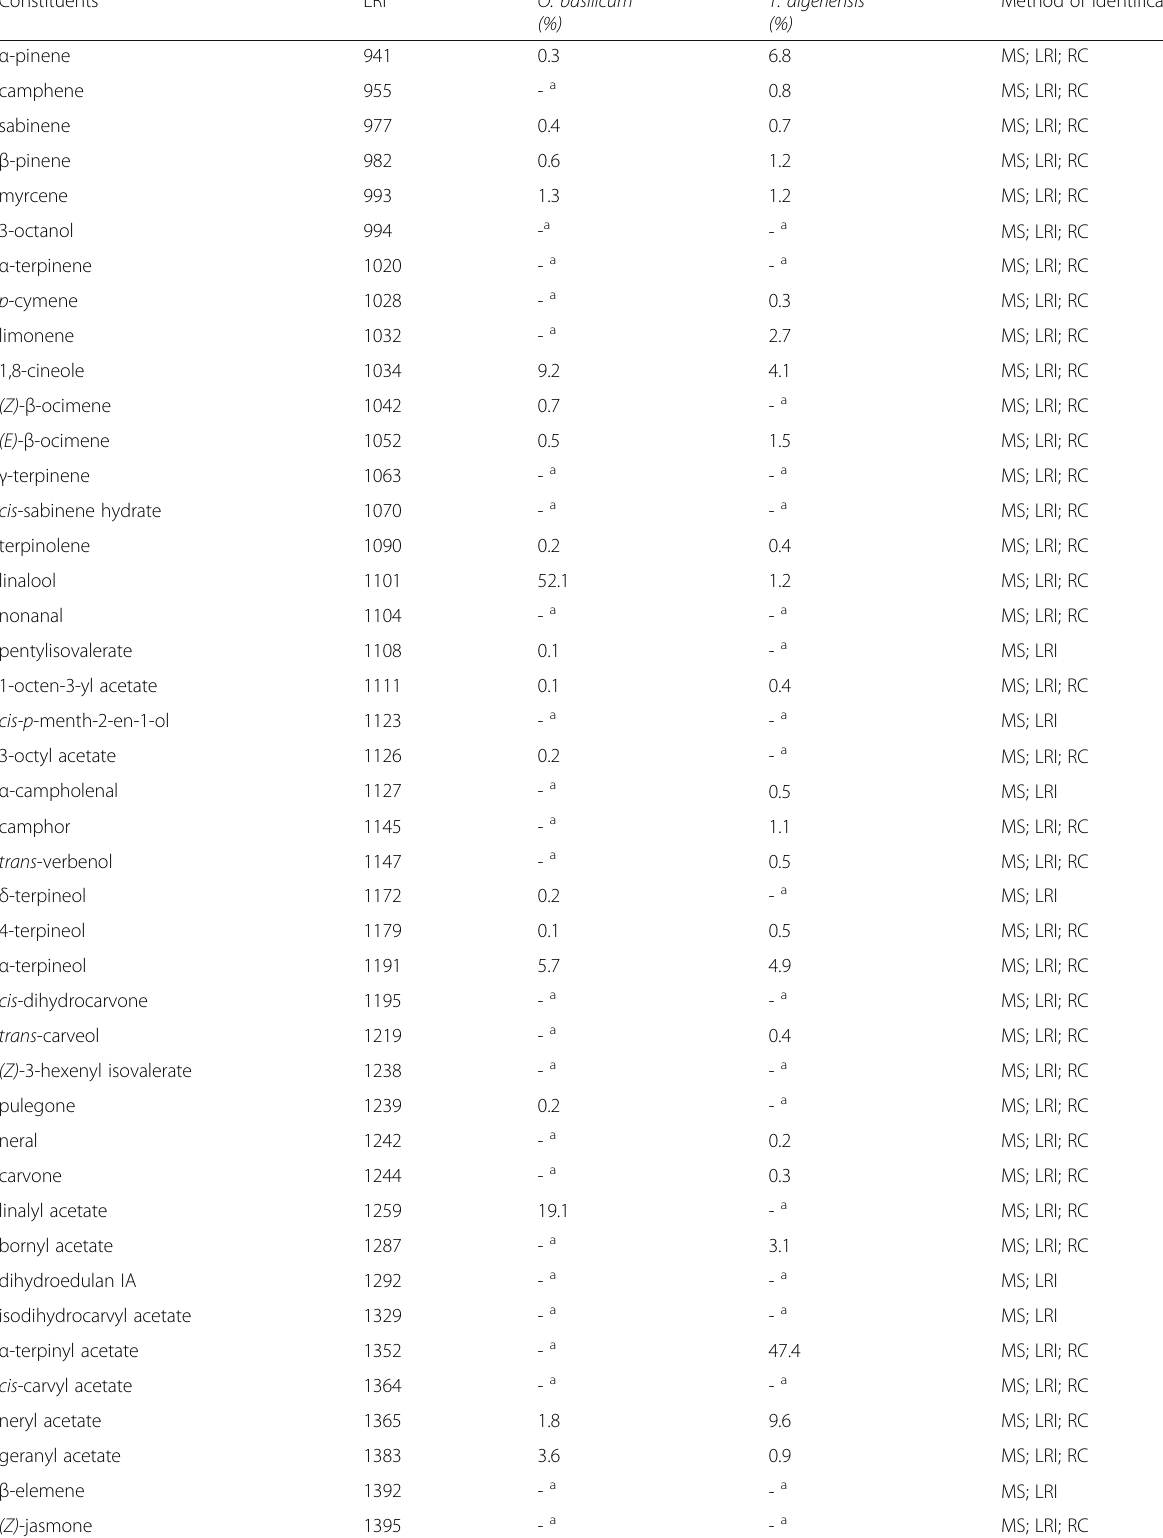
Table 3 Chemical composition of the essential oils extracted from the leaves of O. basilicum and T.